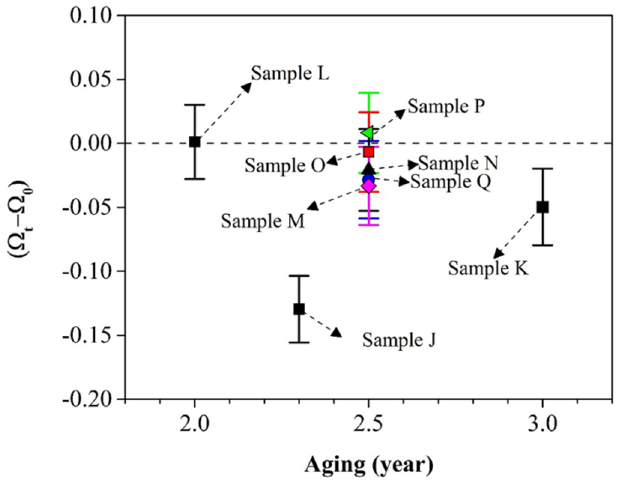
Figure 8. Ω variation over the aging period of samples J, K, L, M, N, O, P, Q. Figure 8. Ω variation over the aging period of samples J, K, L, M, N, O, P,